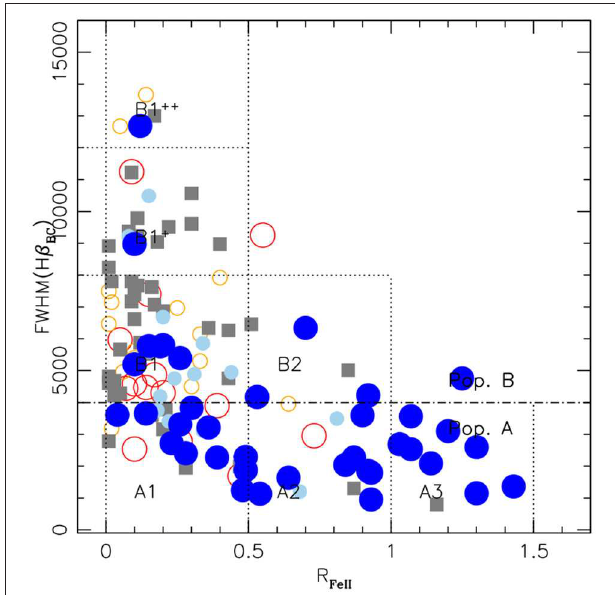
FIGURE 7 | Optical plane of 4DE1 as in Figure 6, for all low- z quasars with measurable HST/FOS UV spectra (Sulentic et al., 2007). Different symbols represent the amplitude of the C IV λ 1549 blueshift at half maximum c ( 1 2 ) normalized by FWHM( H β ) (a measure of the virial broadening): dark blue circles: 1 v r 0.1 , pale blue: 0.1 < 1 v r 0.05 ; gray (unshifted): ≤ − − ≤ − 0.05 < 1 v r 0.05 , pale red: km s − 1 0.05 < 1 v r 0.1 ; red: 1 v r 0.1 . − ≤ + + ≤ + ≥ + Filled symbols: Pop. A, open symbols: Pop. B, squares: RL, circles